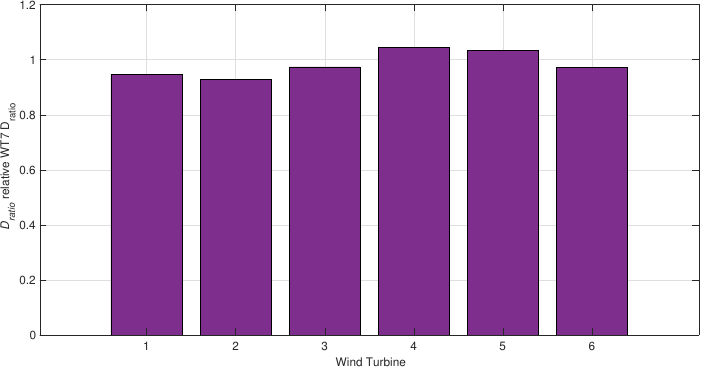
Figure 26. Normalised D ratio using wind rose data only for a range of wind